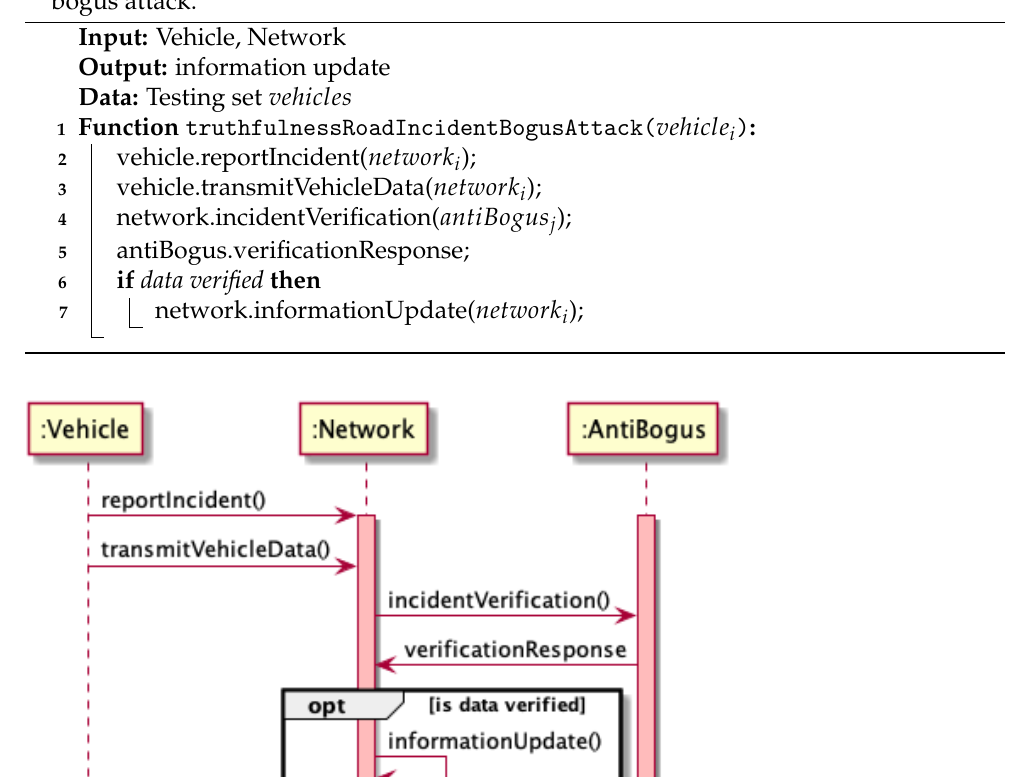
Algorithm 1: Determination of truthfulness of reported road incident during a